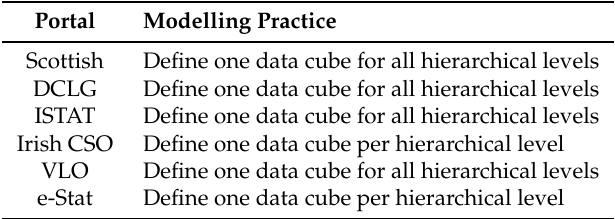
Table 26. Modelling practices of data portals for hierarchical levels. Portal